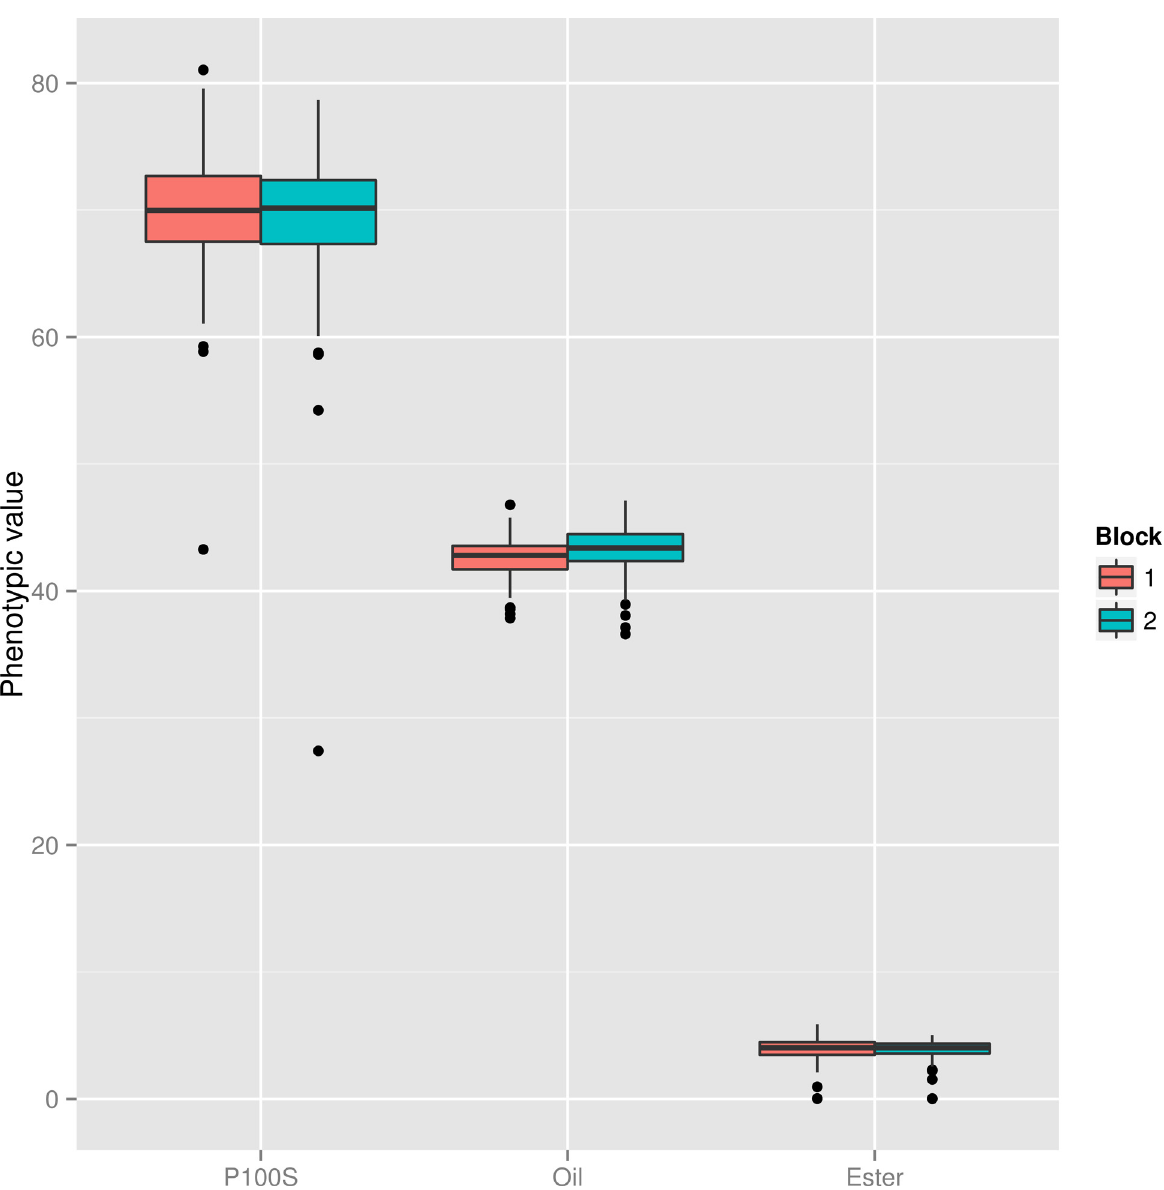
Fig 1. Phenotypic trait evaluation using the Boxplot analysis. Vertical bars are second and third quantiles, and the dots outside the bars are outliers. Each block was evaluated separately, allowing their individual evaluation. W100S – weight of 100 seeds; SOC – seed oil content; PEC – phorbol ester